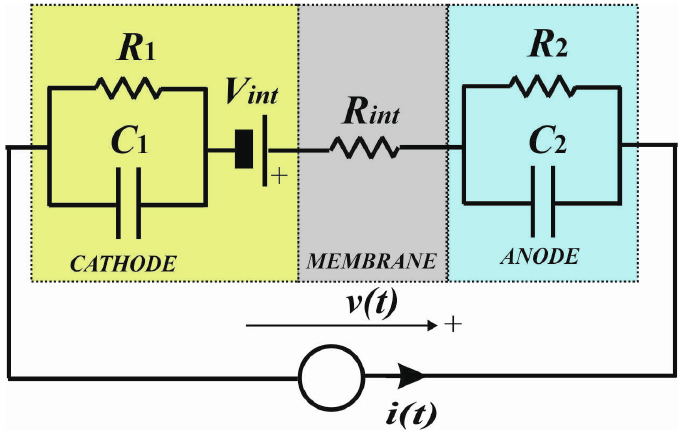
Figure 6. Equivalent circuit of the PEM-EL [31].